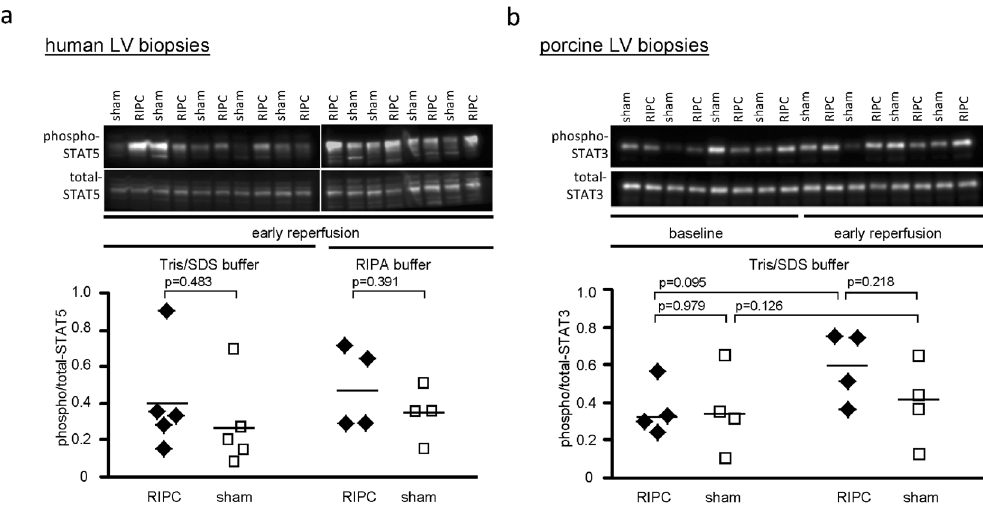
Figure 2. Western blot analysis of phosphorylation/expression of STAT5 in human and of STAT3 in porcine left ventricular biopsies. ( a ) The phosphorylation of signal transducer and activator of transcription 5 (STAT5) at tyr 694 tended to be increased at early reperfusion with remote ischemic preconditioning (RIPC; black symbols) compared to that with sham (white symbols) in human left ventricular (LV) biopsies lysed in Tris/ sodium dodecyl sulfate (SDS) or radioimmunoprecipitation assay (RIPA) buffer. ( b ) The phosphorylation of signal transducer and activator of transcription 3 (STAT3) at tyr 705 tended to be increased from baseline to early reperfusion after coronary occlusion with RIPC, and tended to be greater with RIPC than with sham in porcine LV biopsies. Immunoreactivities of the phosphorylated proteins were normalized to the respective total forms and compared by unpaired (between RIPC and sham) or by paired (between baseline and early reperfusion in pigs) Student’s t-tests. The blots were cropped to display the relevant bands, full-length blots and Ponceau-S stainings are presented in Supplemental Fig.